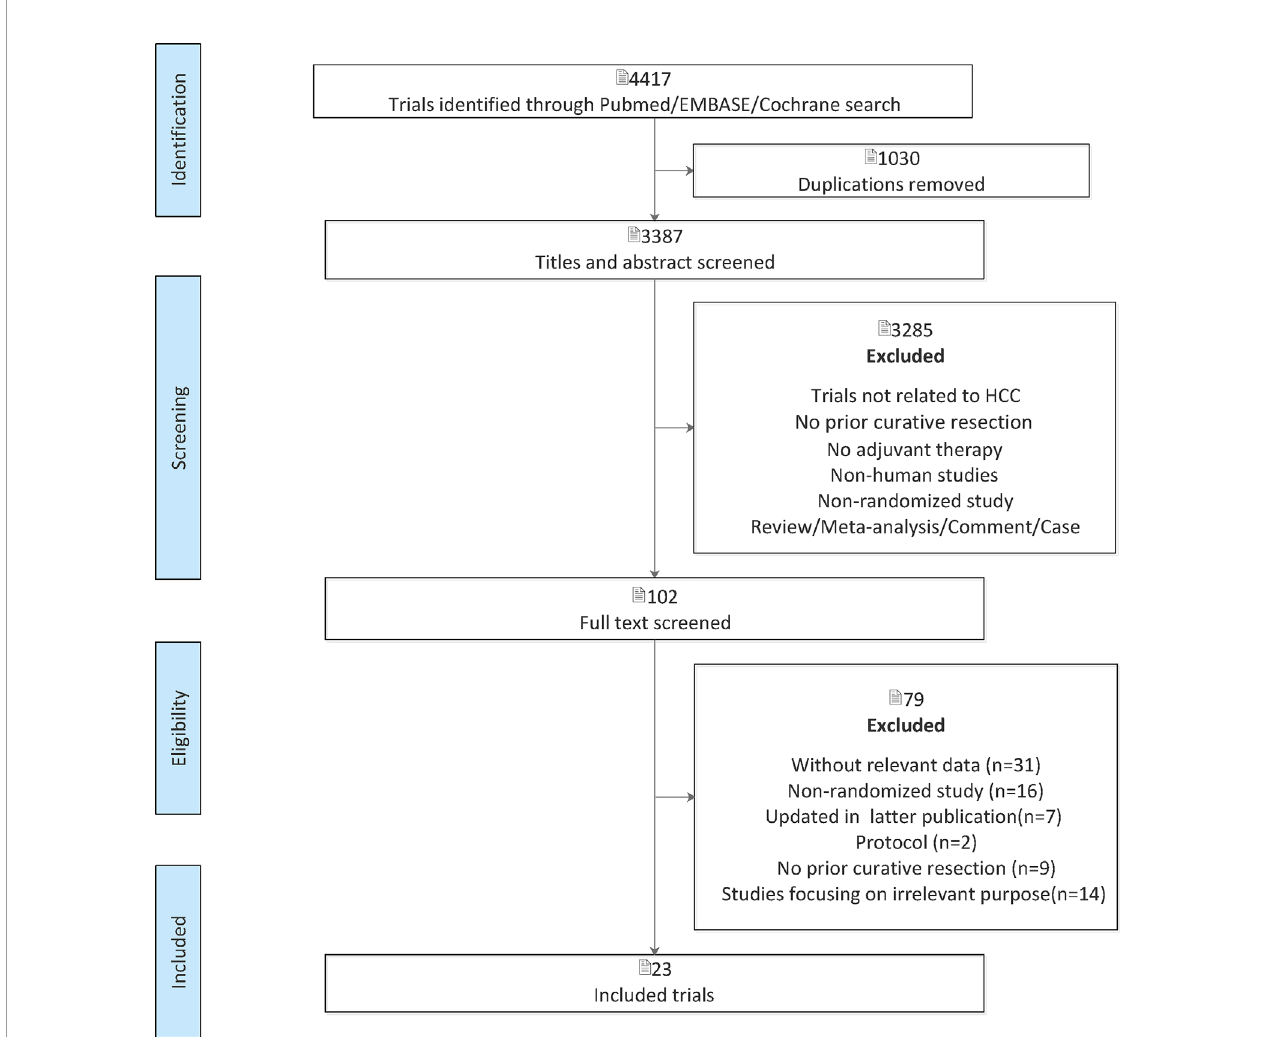
FIGURE 1 | PRISMA (Preferred Reporting Items for Systematic Reviews and Meta-Analyses) fl ow